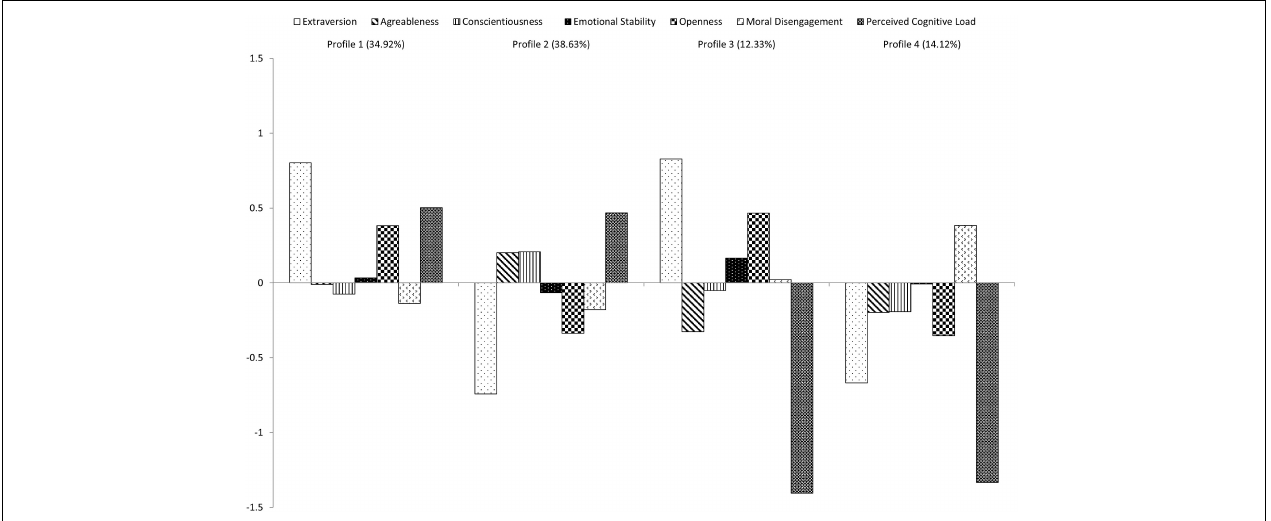
FIGURE 1 | Latent profile analysis plot describing the scores of personality, morality, and perceived cognitive load for each profile. The scores of the six variables which constitute the profiles (personality, moral disengagement, and perceived cognitive load) are reported as Z-scores and their deviation from the grand